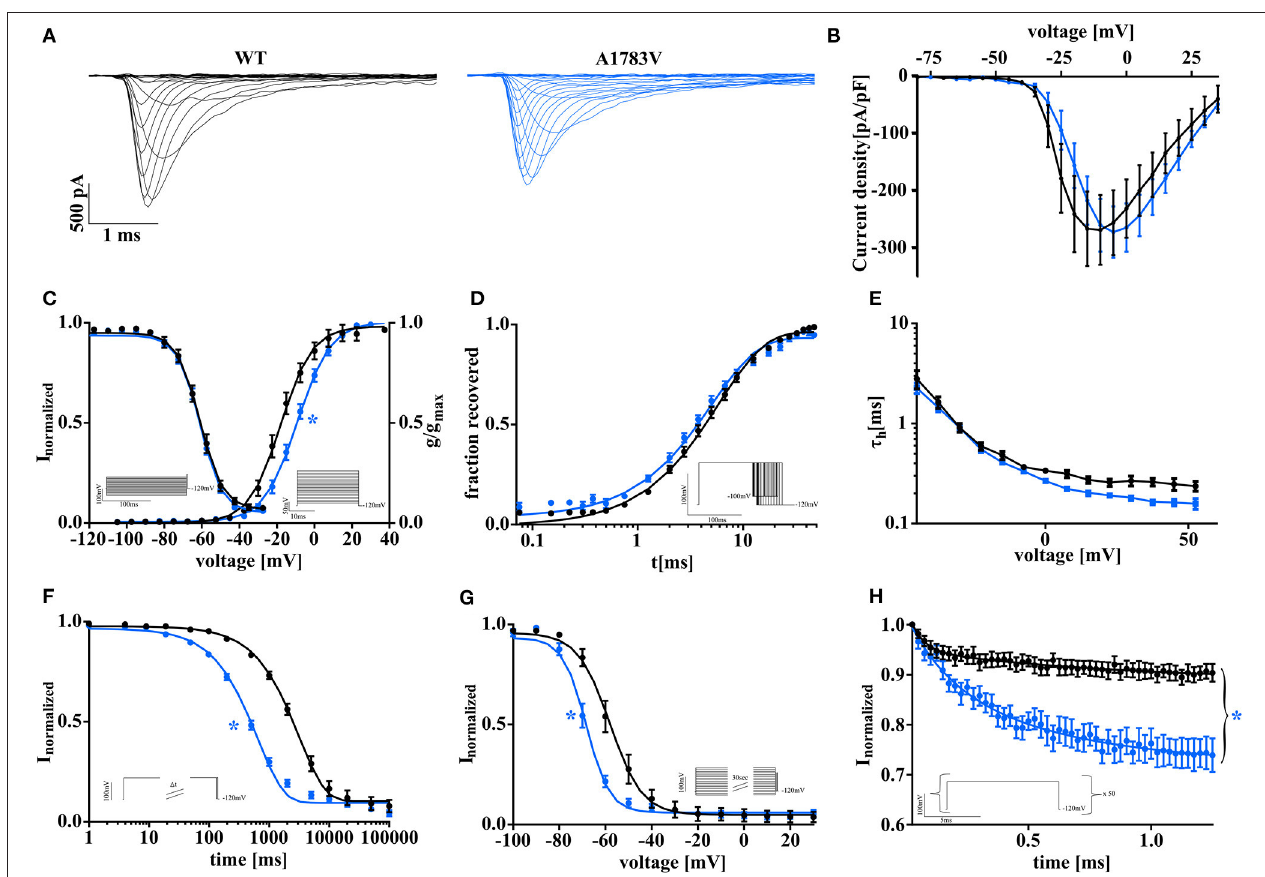
FIGURE 1 | Biophysical properties of SCN1A wild type and mutant Na V 1.1 A1783V channels recorded in tsA201 cells display a clear loss of function. (A) Representative current traces were recorded from tsA201 cells transfected with Na V 1.1 WT (black traces) or Na V 1.1 A1783V (blue traces). (B) Peak Na + currents normalized by cell capacitance were plotted vs. command voltage and revealed no changes between wild-type (WT) and mutant Na V 1.1 A1783V channels. ( C , right) Voltage-dependence of steady-state activation curves represented as normalized conductance fit by a Boltzmann function to the data points (lines). ( C , left curve) Voltage-dependent state of fast inactivation fit by a Boltzmann function to the data points (lines). (D) Time course of recovery from fast inactivation at − 100mV. (E) Voltage-dependence of the time constant of fast inactivation τ h analyzed by a one exponential fit to inactivating phase of the Na + currents. (G) Entry into slow inactivation is represented as a first-order exponential fit to the data points. (H) Voltage-dependent steady-state of slow inactivation fit by a Boltzmann function as in (C) . (F) Na-current use dependence evoked by 50 pulses at a frequency of 40Hz as normalized peak currents plotted against the time and fit by a second-order exponential function. The number of recorded cells, exact values of statistically analyzed parameters, and p -values are listed in Supplementary Table 1